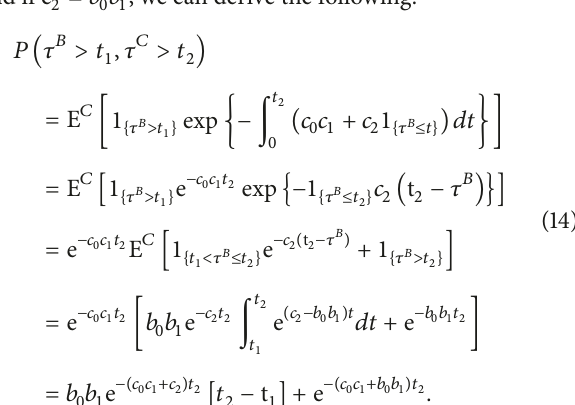
Figure 1: The triangular fuzzy risk-free interest rate.